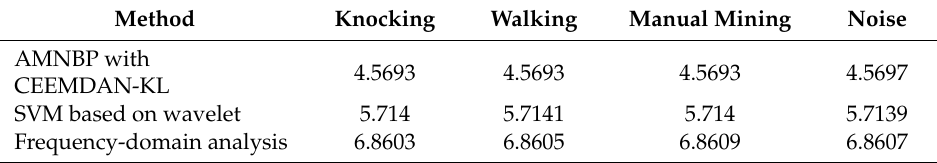
Table 4. The e ffi ciency results of four types of events (in